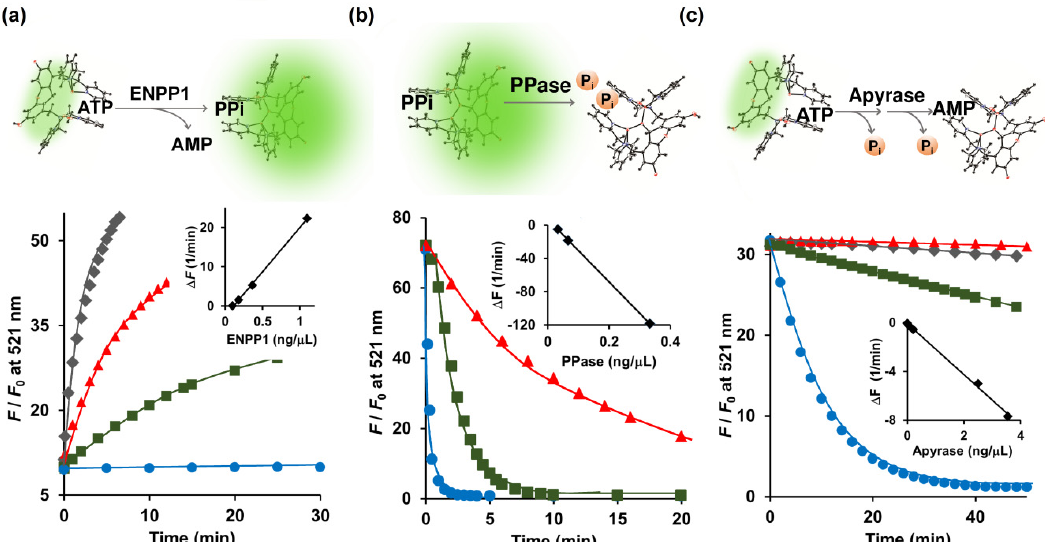
Figure 2. ( a ) Conversion of ATP (5 µ M) to PPi catalyzed by ENPP1; ( b ) Degradation of PPi (1 µ M) to Pi catalyzed by inorganic PPase; ( c ) Hydrolysis of ATP (2 µ M) to AMP catalyzed by apyrase monitored real-time in a 0.7-mL cuvette by 1 µ M Kyoto Green. Measurement conditions: 50 mM HEPES bu ff er, Table 1. Maximum fluorescence change ( ∆ F ) of Kyoto Green in real-time monitoring of ENPP1, PPase, and apyrase activities. Substrate ENPP1 PPase Apyrase ATP + 48.72 product 1 − 70.18 − 0.03 1 PPi is the product of ATP hydrolysis catalyzed by ENPP1.